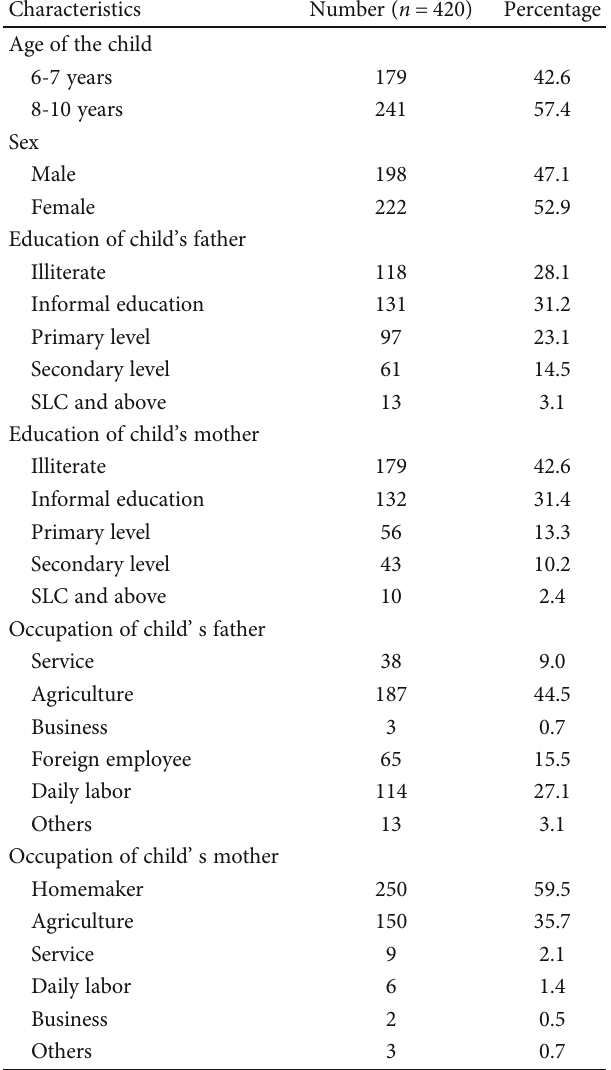
Table 1: Background related characteristics of study